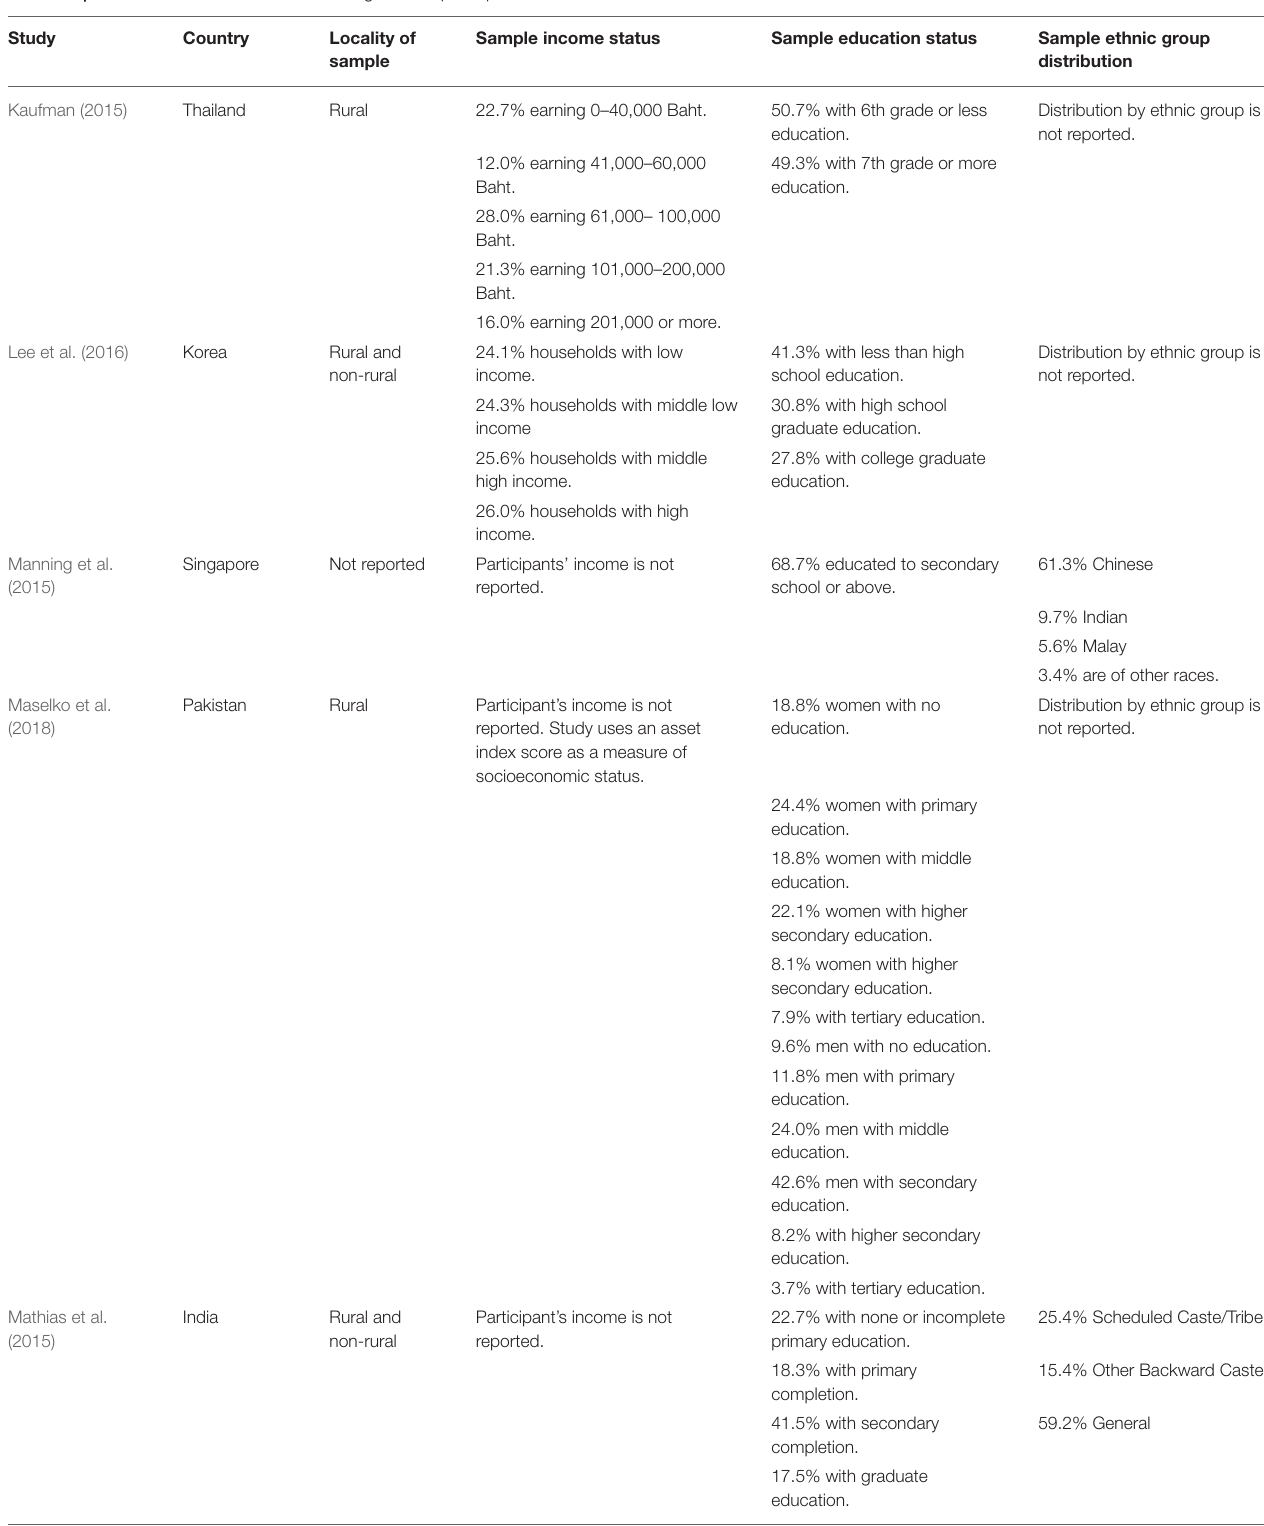
TABLE 2 | The characteristics and culture background of